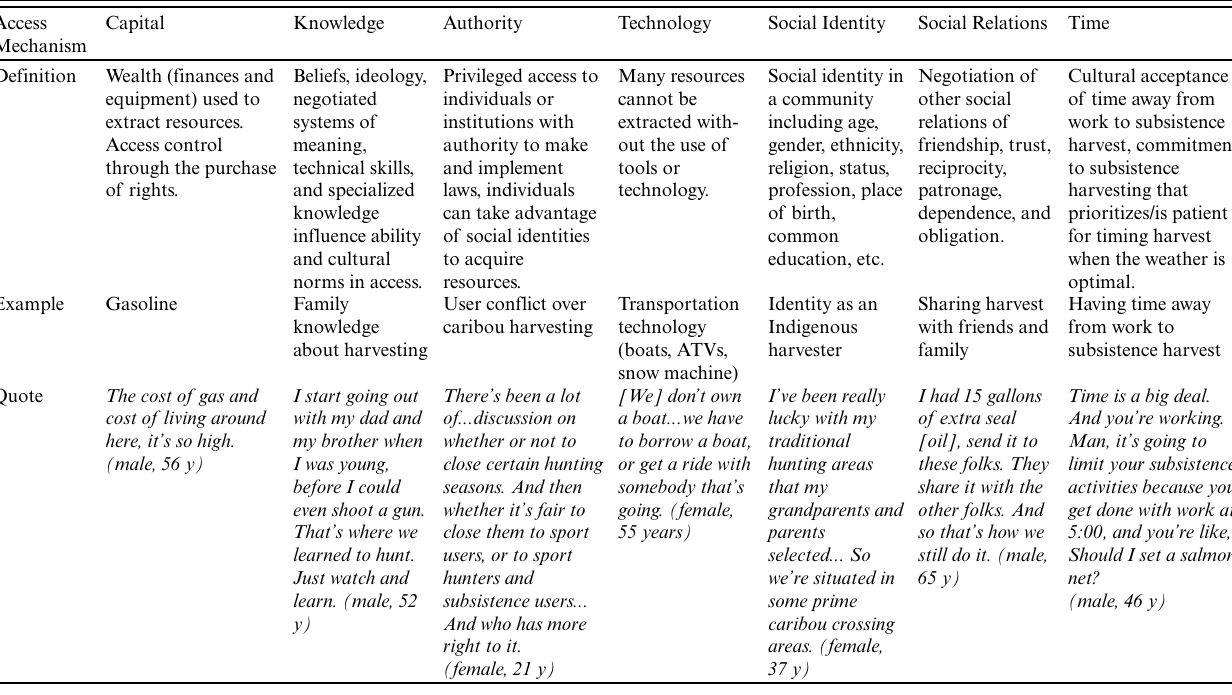
Table 2 . Access mechanism definitions (Ribot and Peluso 2003), examples from subsistence harvester interview data, and illustrative quotes from subsistence harvester